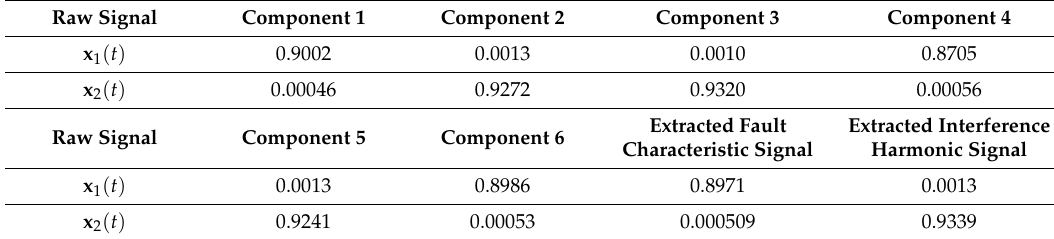
The correlation coe ffi cients between extracted signals or the six one-dimensional single-component signals and the original two characteristic signals.